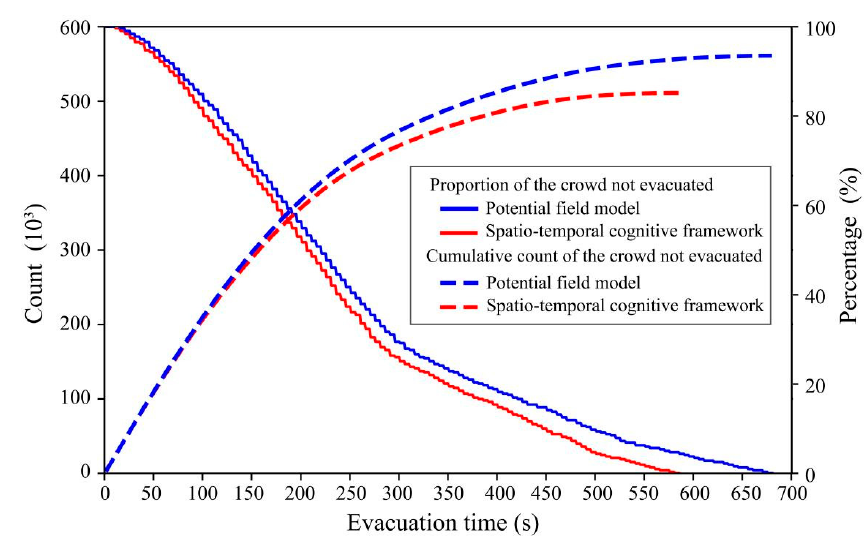
18 of 26 Table 2. The performance of route choice strategies of two route choice models. Evaluation Matric Potential Field Model